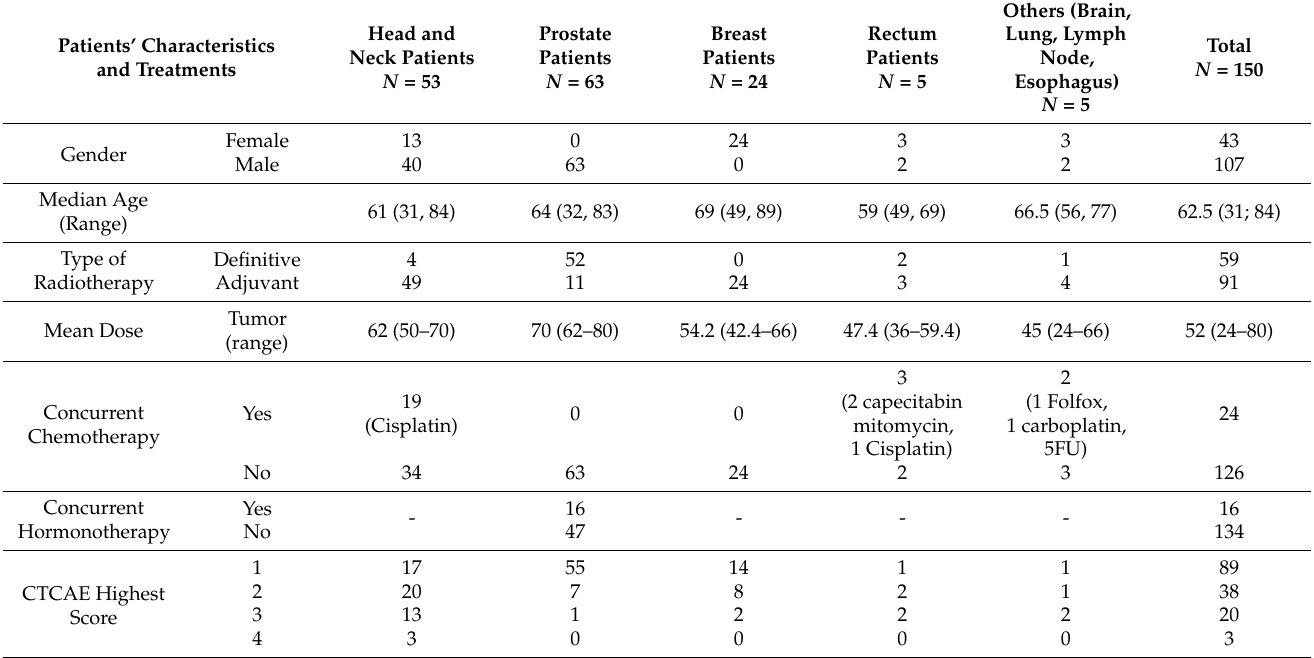
Table 1. Training cohort: 150 patients’ characteristics and treatments.